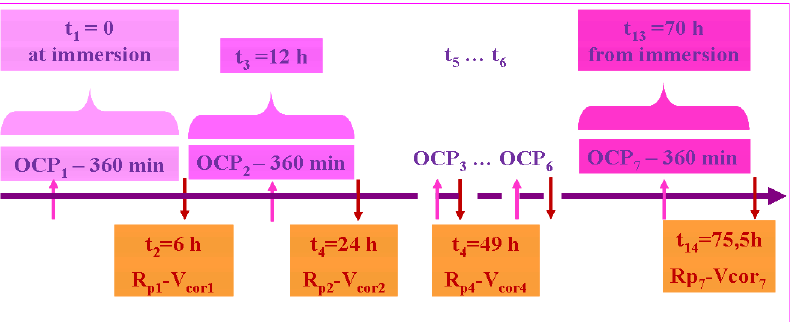
Figure 2. Experimental protocol summarizing the sequential electrochemical measurements during the total immersion period in biological solution.